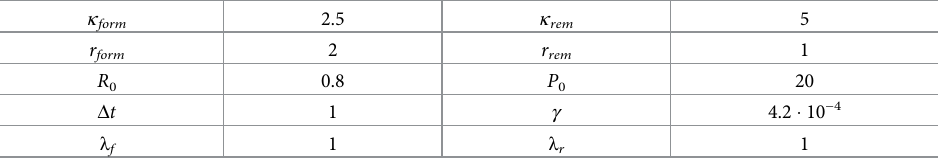
Table 2. Table of parameters for the resource-pool model (unless stated